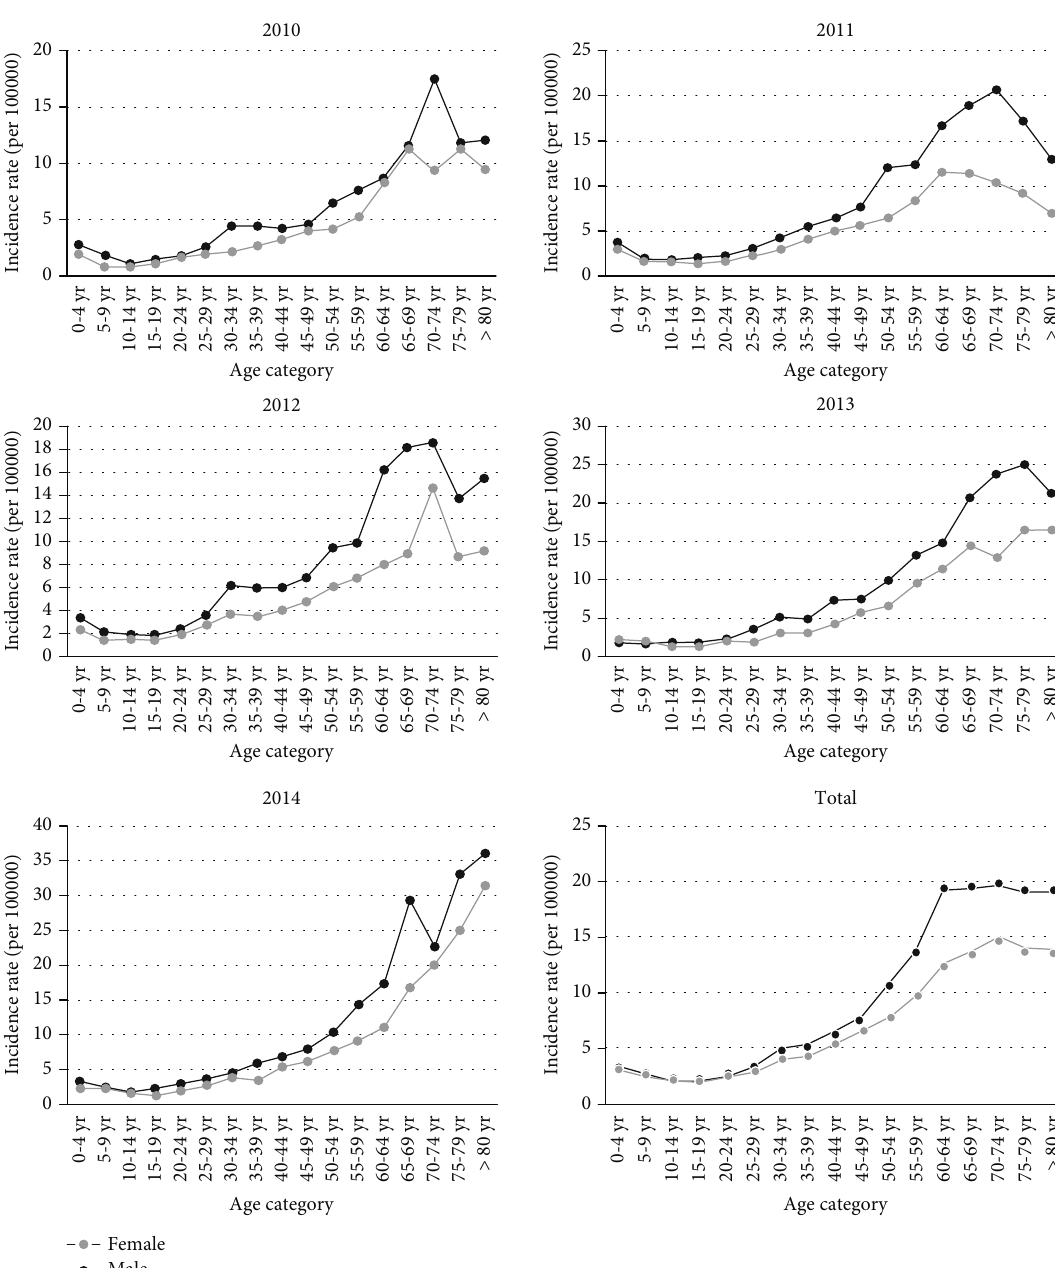
Figure 1: Crude incidence rates by gender and age in each year and the whole